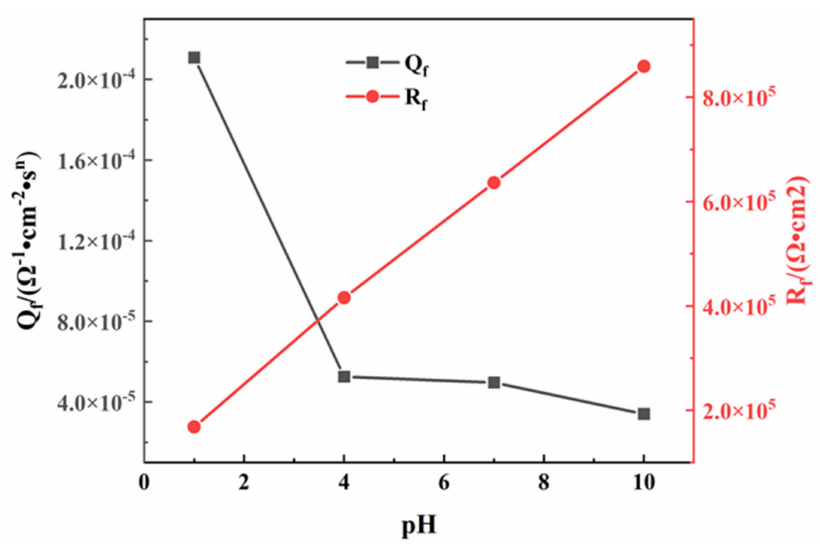
Figure 4. Variations in Q f and R f as a function of pH.